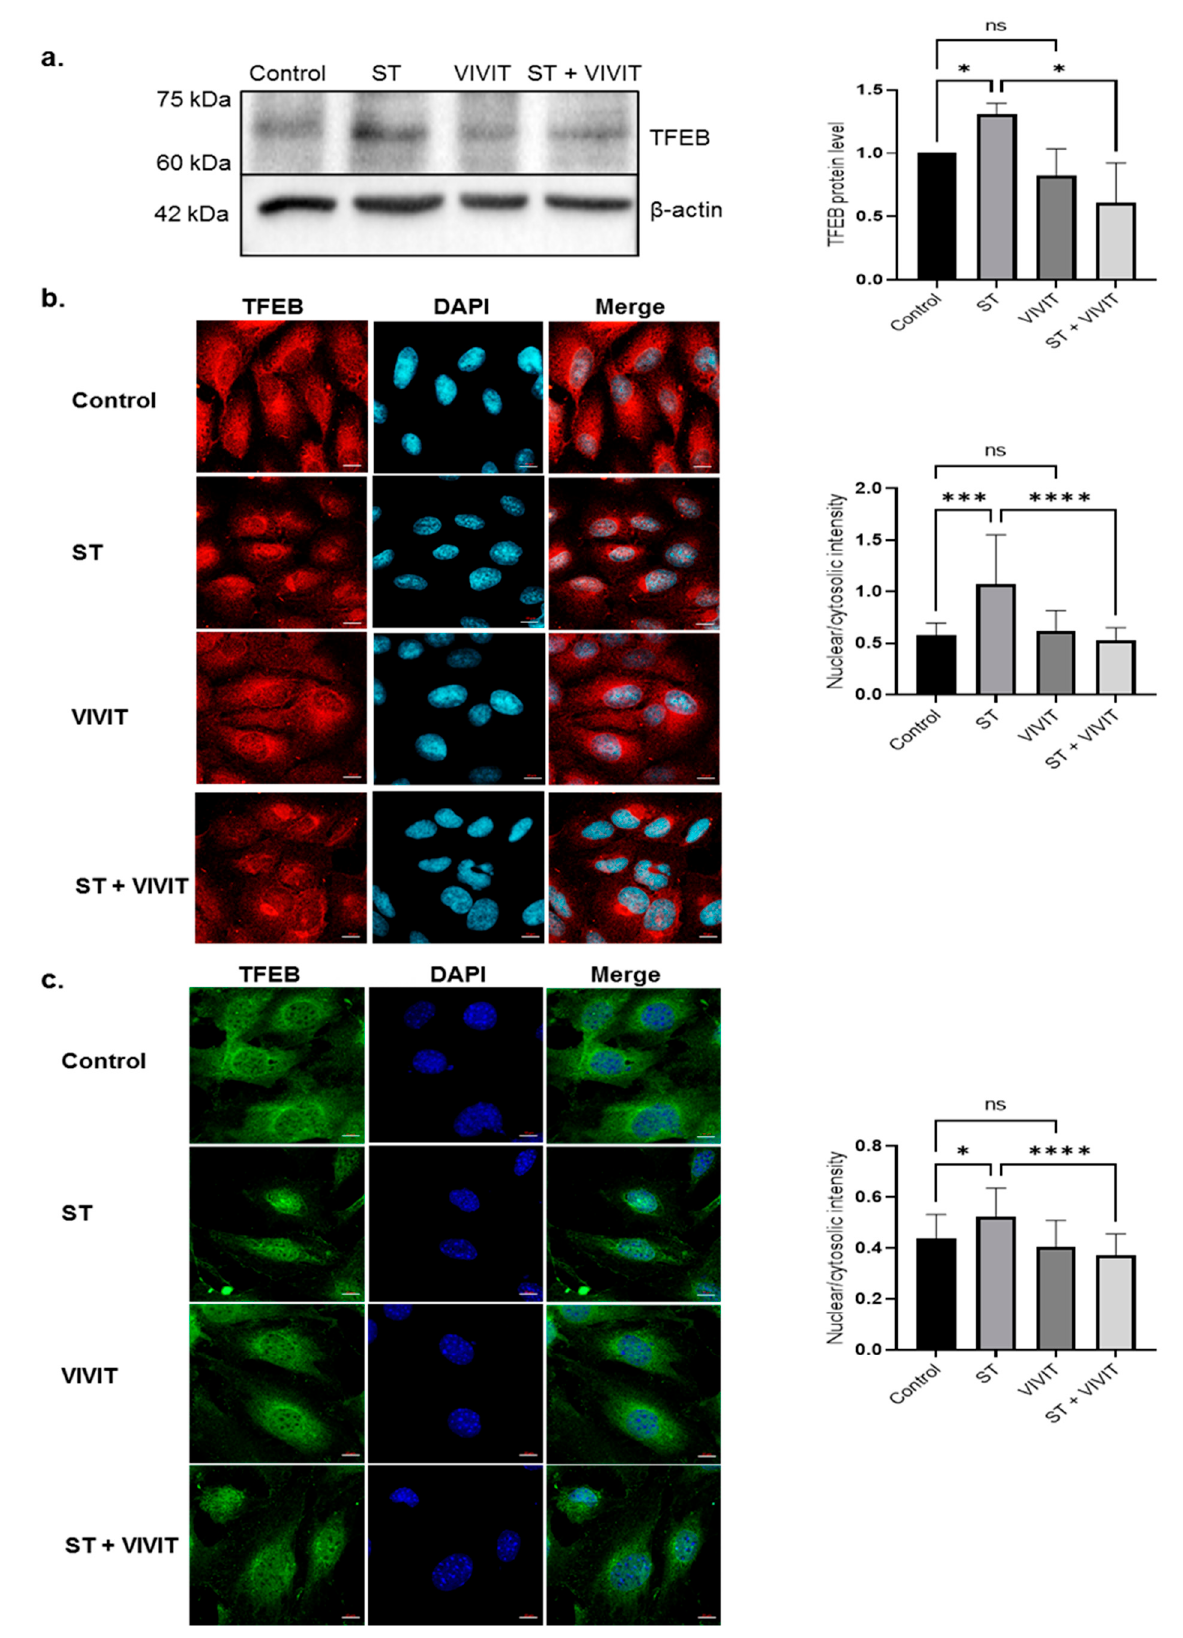
Figure 3. NFAT-mediated regulation of TFEB expression and activity. ( a ) Immunoblot analysis of expression of TFEB in ARPE-19 cells treated 20 µM VIVIT and subjected to 48 h period of nutrient deprivation. ( b ) Nuclear and cytosolic localization of TFEB in ARPE-19 was examined by immunostaining with TFEB antibody. ( c ) Nuclear and cytosolic